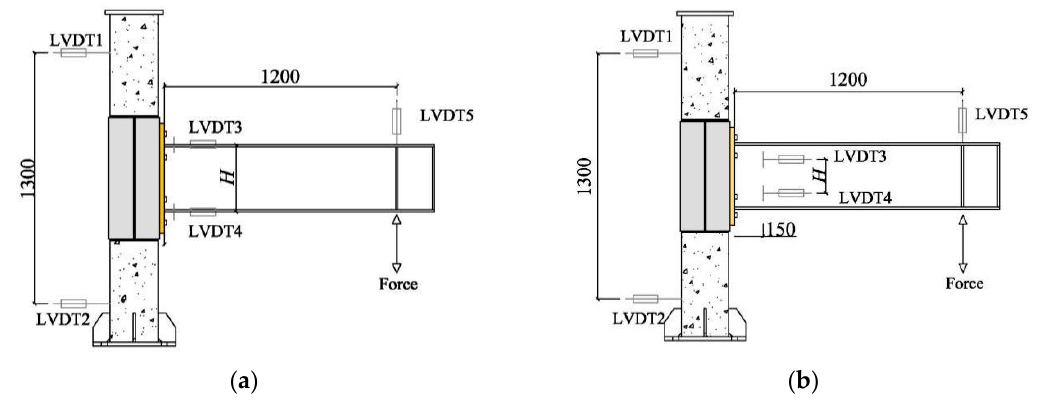
Figure 6. Arrangement of LVDTs for specimens (units: mm). ( a ) SJ-1 through SJ-5; ( b ) SJ-6 through SJ-8.